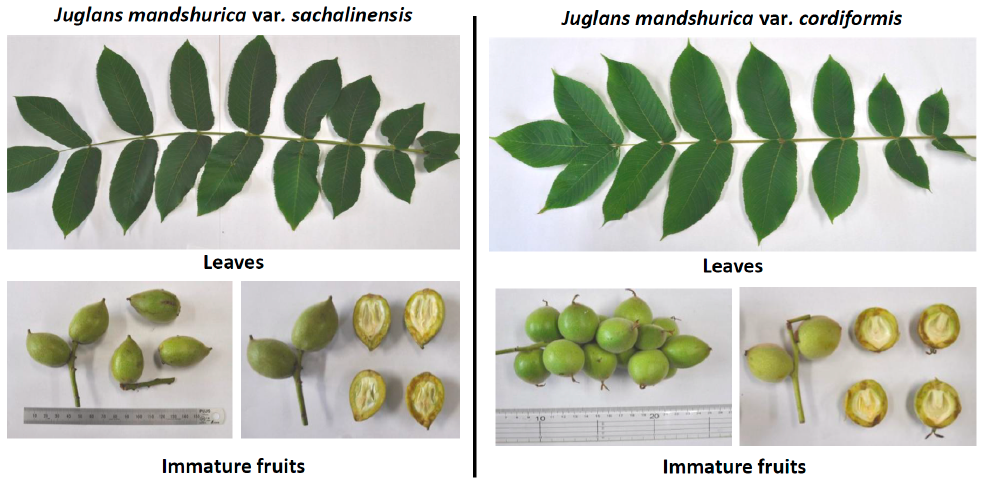
Figure 1. The photographs of leaves and immature fruits of J. mandshurica var. sachalinensis and J. mandshurica var. cordiformis